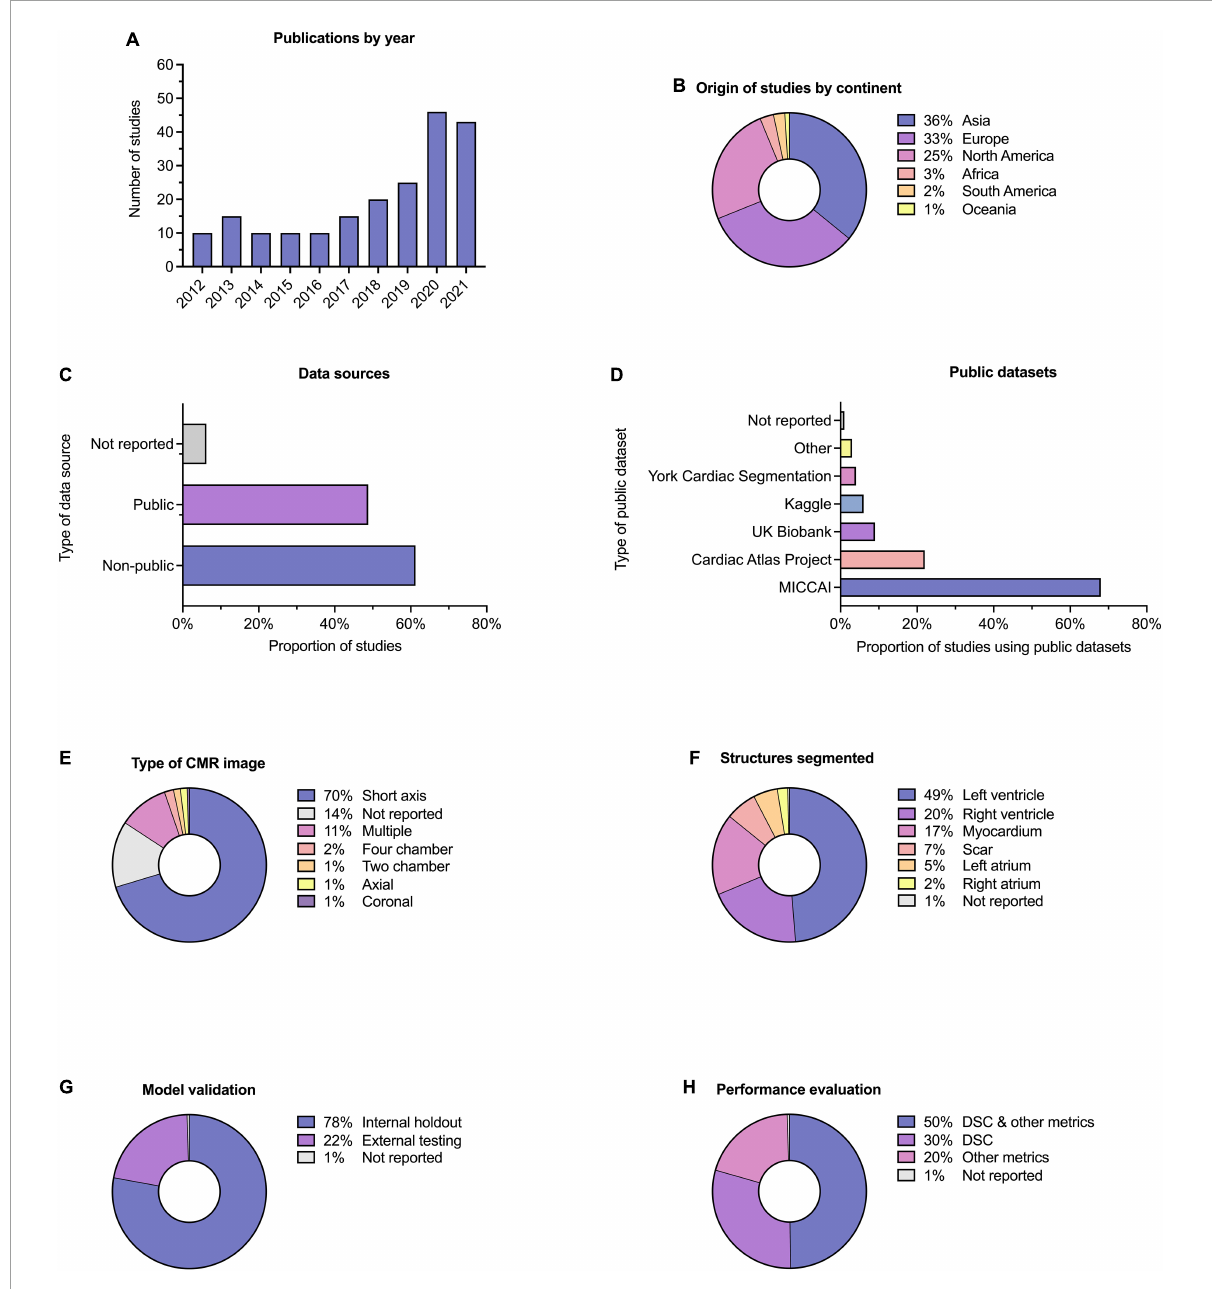
FIGURE3 Descriptive information. Descriptive information for the 209 included studies. (A) Publication dates; five studies (2.4%) were included from early 2022 and are not indicated here. (B) Location of origin of studies. (C) Data sources; the proportion of studies which used public and non-public datasets is shown, with some studies having used multiple or combined datasets. (D) Public datasets used by studies, where relevant. (E) Type of CMR images used. (F) Cardiac structures segmented; some studies performed segmentation on multiple structures. (G) Method of model validation. (H) Method of model performance